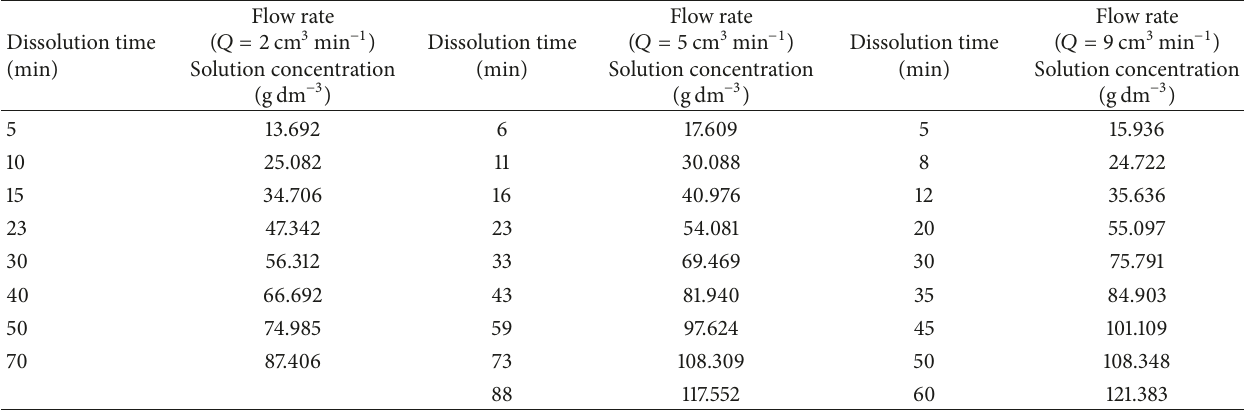
Table 1: Results of transient dissolution tests of rock salt.